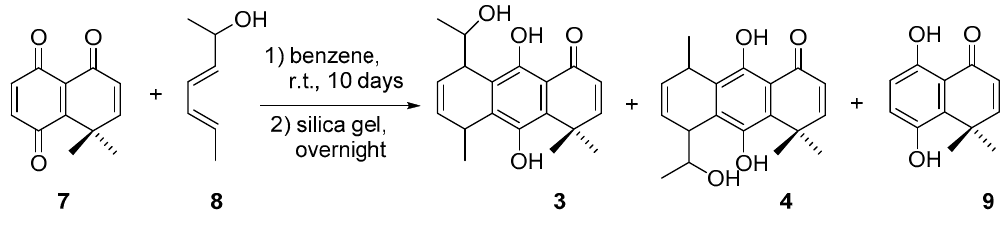
Figure 1. Structure of molecules studied in this work.